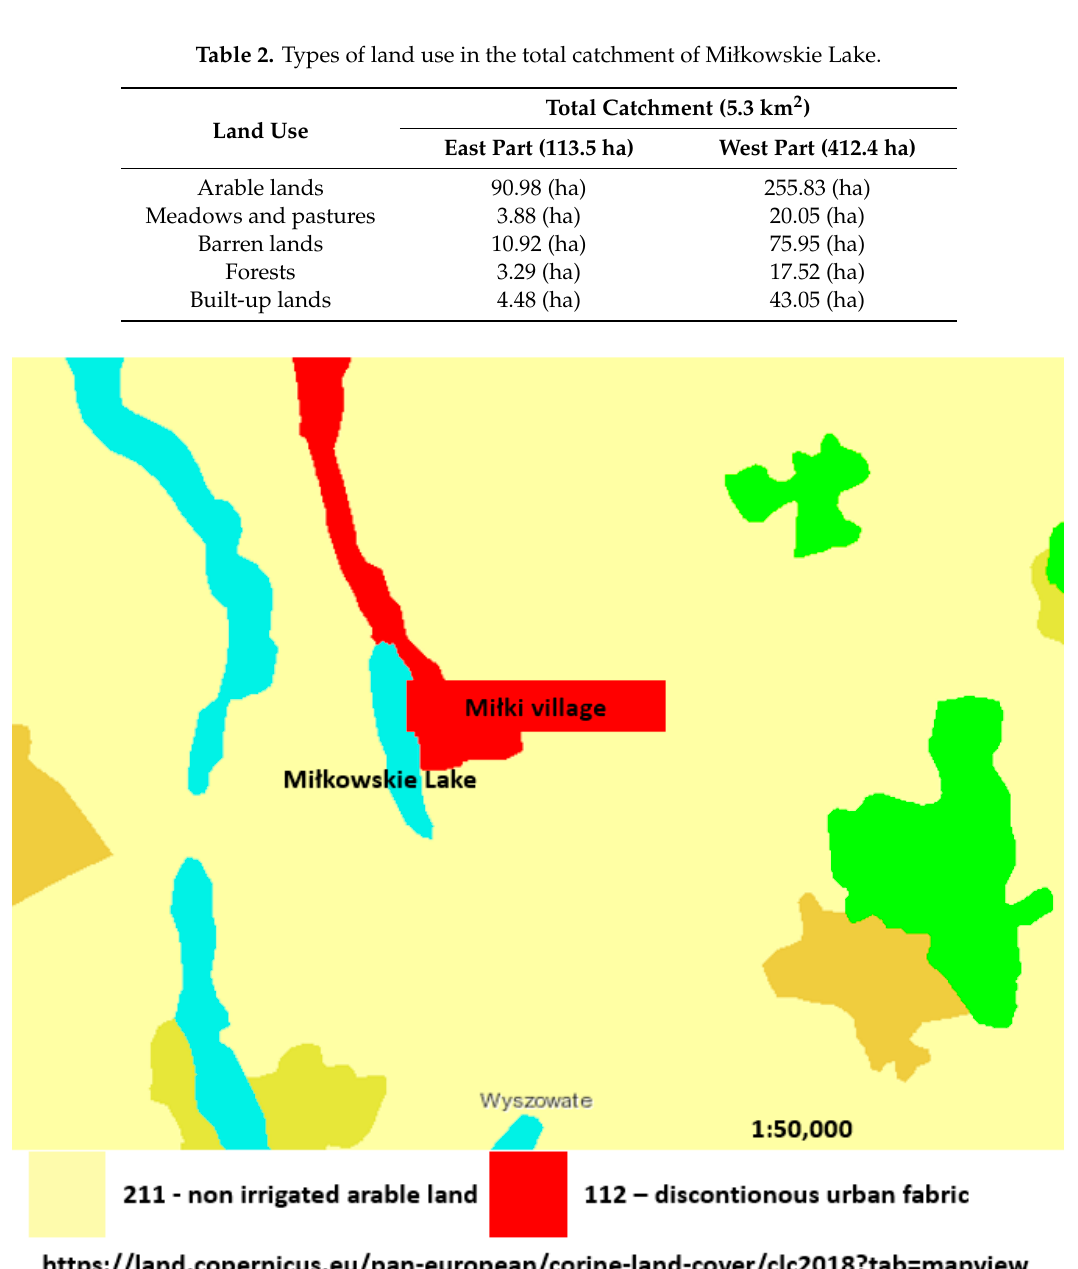
Figure 2. Forms of land cover in the catchment area of Mi ł kowskie Lake.